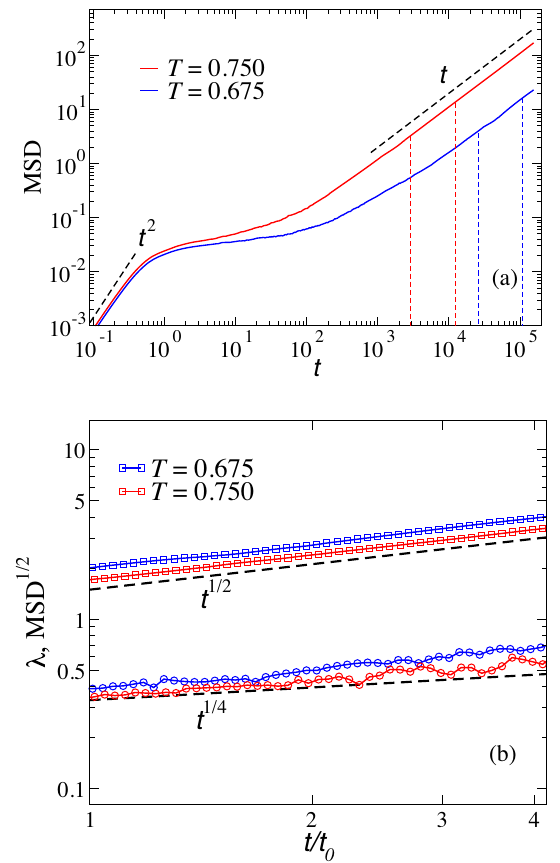
FIG. 6. MSD and Brownian yet non-Gaussian regime for the 4D Kob-Andersen binary mixture. (a) Double-log plot of the MSD for the two temperatures investigated, covering the whole time regime from ballistic to diffusive motion. We mark by vertical dashed lines the time windows correspond- ing to the analyzed Brownian yet non-Gaussian regime for each temperature. (b) Double-log plot of MSD 1 = 2 (squares) and λ (circles) as a function of time for the 4D Kob-Andersen binary mixture at different temperatures: T ¼ 0 . 750 and 0.675. Here, t 0 is the temperature-dependent time at which the system reaches a μ value compatible with 1 within numerical uncertainty, i.e., MSD( t ≥ t 0 ) ∼ t μ ≅ 1 (see Sec. VI). The analyzed time windows correspond to the time regimes signaled by vertical dashed lines in (a). Dashed lines representing power-law behaviors in (a) and (b) serve as a